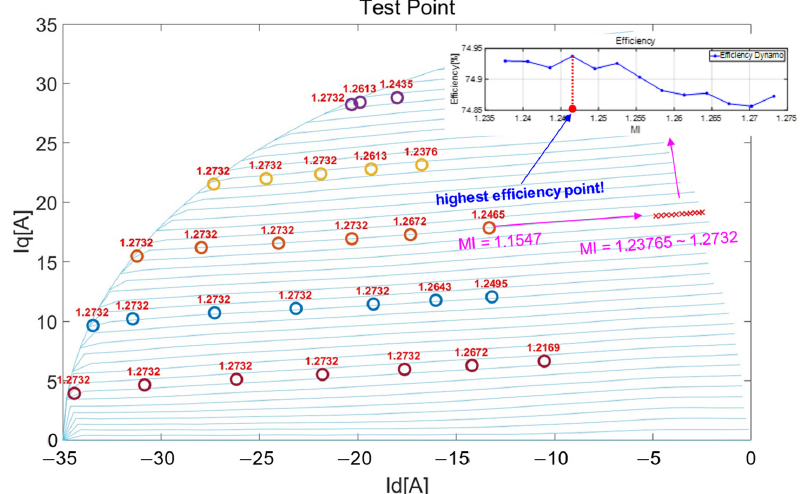
Figure 15. Test point used for creating an optimal MI table.